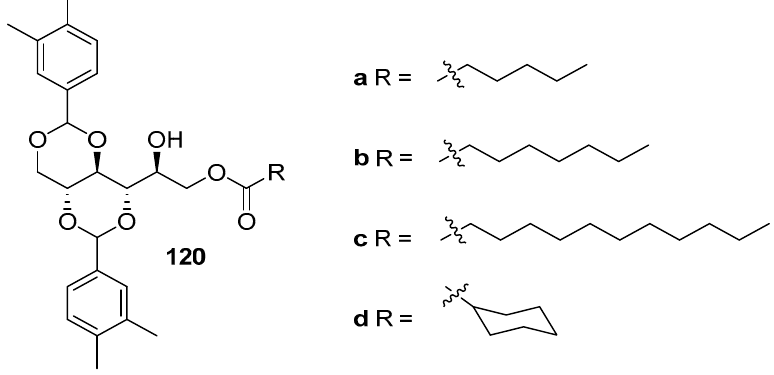
Figure 73. Sorbitol based supramolecular gelator [131].